Question: Write a single sentence explaining what this figure depicts.
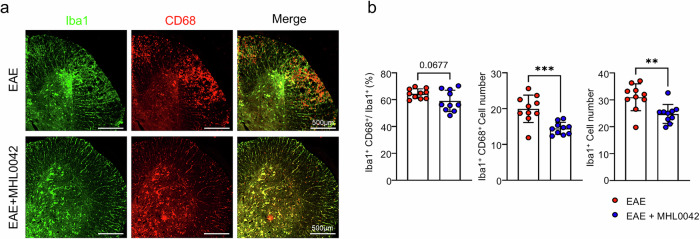
Answer: Veillonella ratti MHL0042 treatment suppresses microglia activation in experimental autoimmune encephalomyelitis mice. a Immunofluorescence staining of Iba1 + (green) and CD68 + (red) cells in the white matter of the spinal cord from experimental autoimmune encephalomyelitis (EAE) and EAE + V. ratti MHL0042 groups. Images are representative of 10 independent mice per group. b Quantification of the percentage of Iba + CD68 + cells among total Iba + cells, as well as absolute numbers of Iba + CD68 + and Iba + cells in EAE and EAE + V. ratti MHL0042 groups. Each dot represents the average of minimum three sections from an individual mouse. Data are presented as mean ± standard deviation from EAE ( n = 10) and EAE + V. ratti MHL0042 ( n = 10) groups. Statistical comparisons were performed using two-tailed unpaired t test. ** P < 0.01; *** P < 0.001.